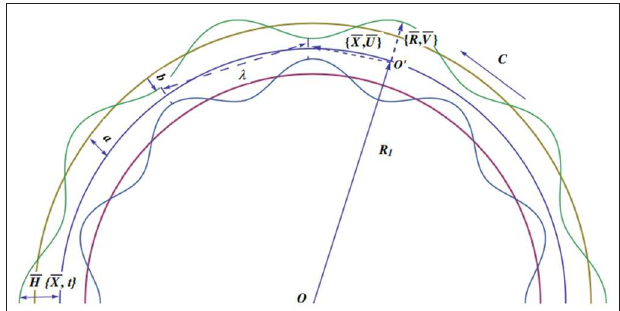
FIGURE 1 | Schematic diagram of the